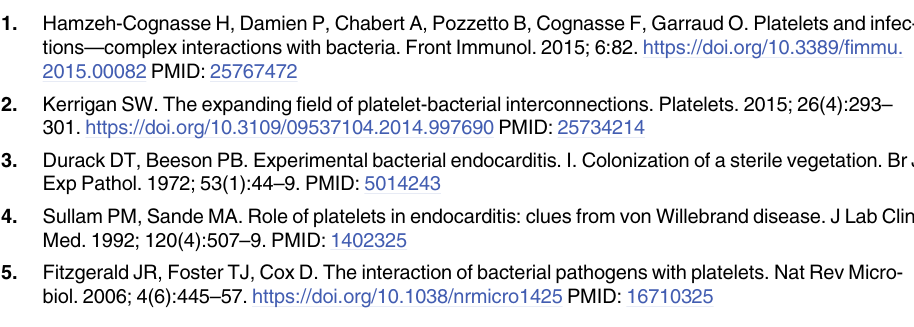
S1 Fig. Coomassie stain and uncropped Western blot and of cell wall proteins extracted from S . gordonii M99 and isogenic variant strains. Lanes contain cell wall proteins extracted from bacteria in 75 μ l of stationary-phase cultures cultures (roughly 7.5 x 10 7 CFU; lanes 1–4) or, to enhance visibility of the proteins, from 200 μ l of stationary-phase cultures (roughly 2 x 10 8 CFU; lanes 5–8). Gels were either stained with Coomassie (left panel) or transferred to nitrocellulose and probed with polyclonal antibodies that recognize the glycan moieties on GspB (right panel). Lanes 1 and 5, the Δ 5’ gspB strain PS2114 (no GspB expressed); lanes 2 and 6, M99 (GspB wild-type); lanes 3 and 7, PS3515 (GspB::Hsa ); lanes 4 and 9, PS3516 BR (GspB::10712 ); lanes marked "M" contain molecular weight markers (250, 150, 100, 75, 50 BR and 37 kDa from top to